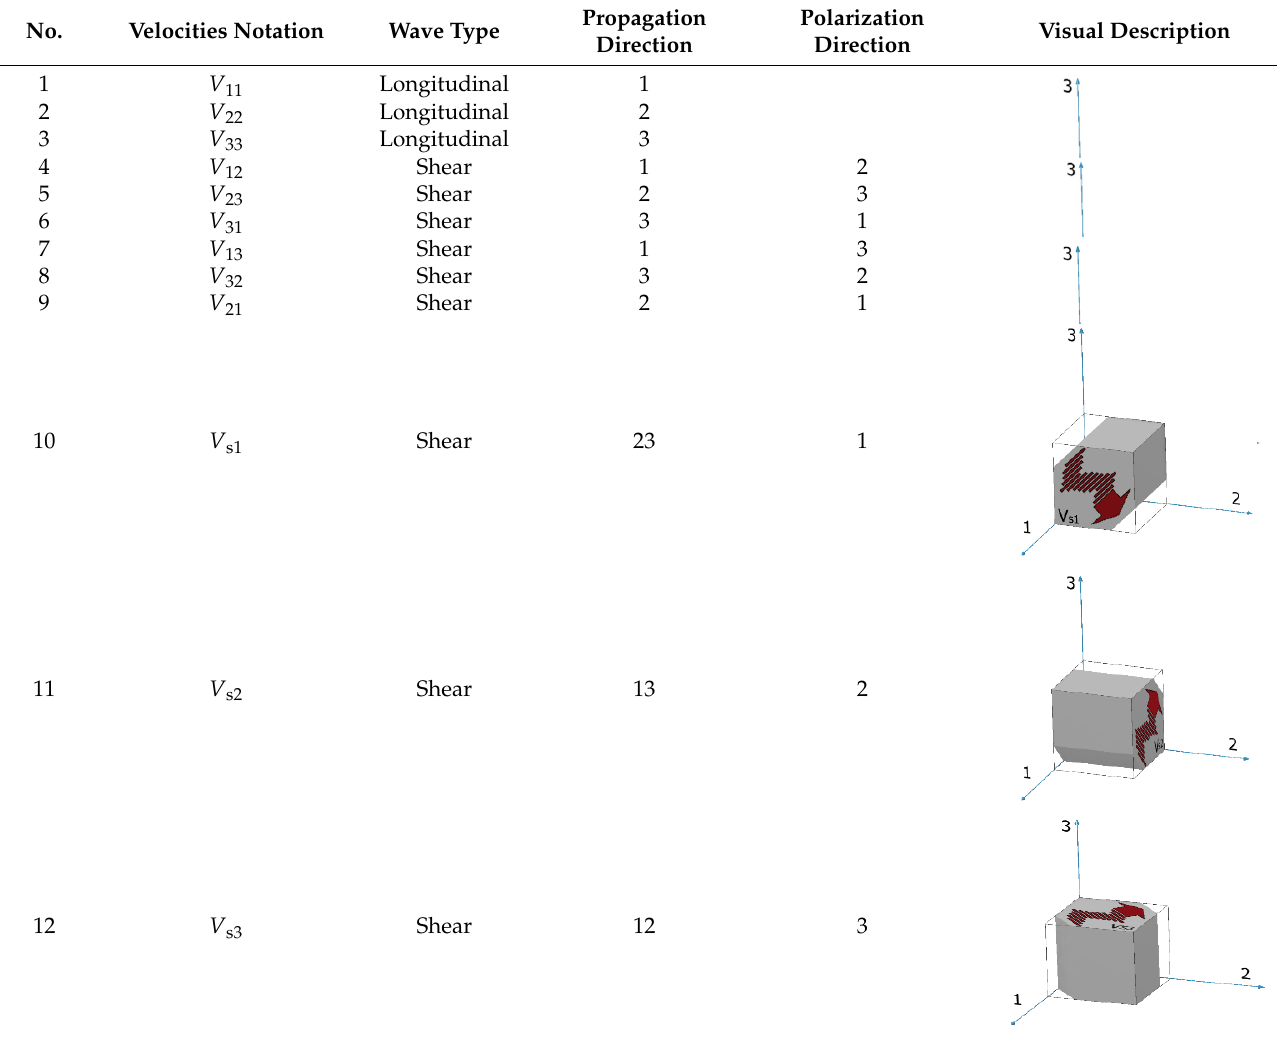
Table 1. Twelve sound wave velocities measured using the polygon method.